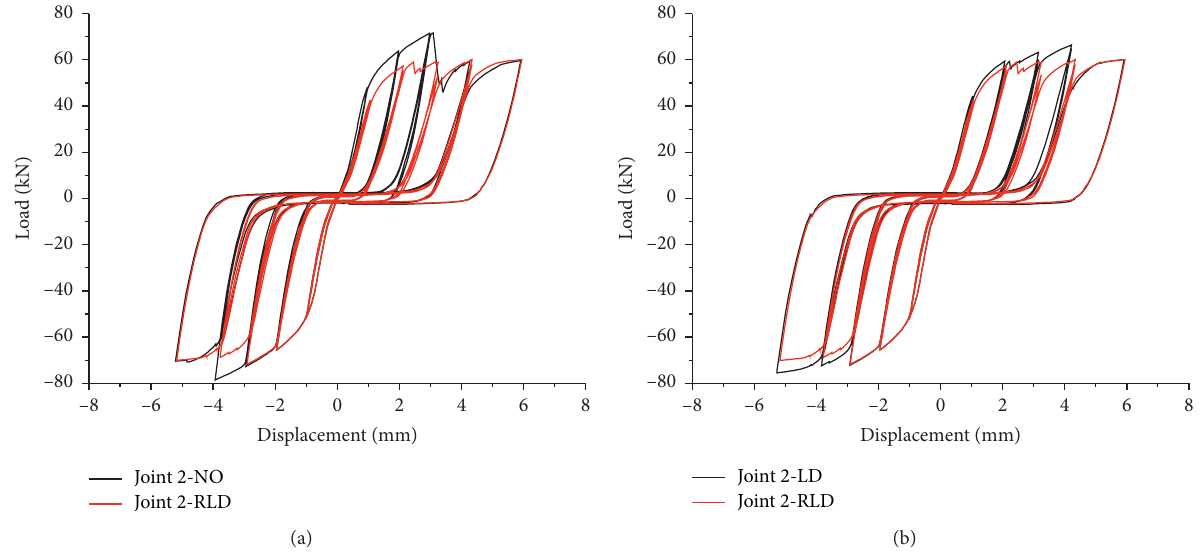
Figure 15: Hysteretic curves of Joint 2: (a) comparison between initially perfect Joint 2 and Joint 2-RDT; (b) comparison between Joint 2-LD and Joint 2-RLD.